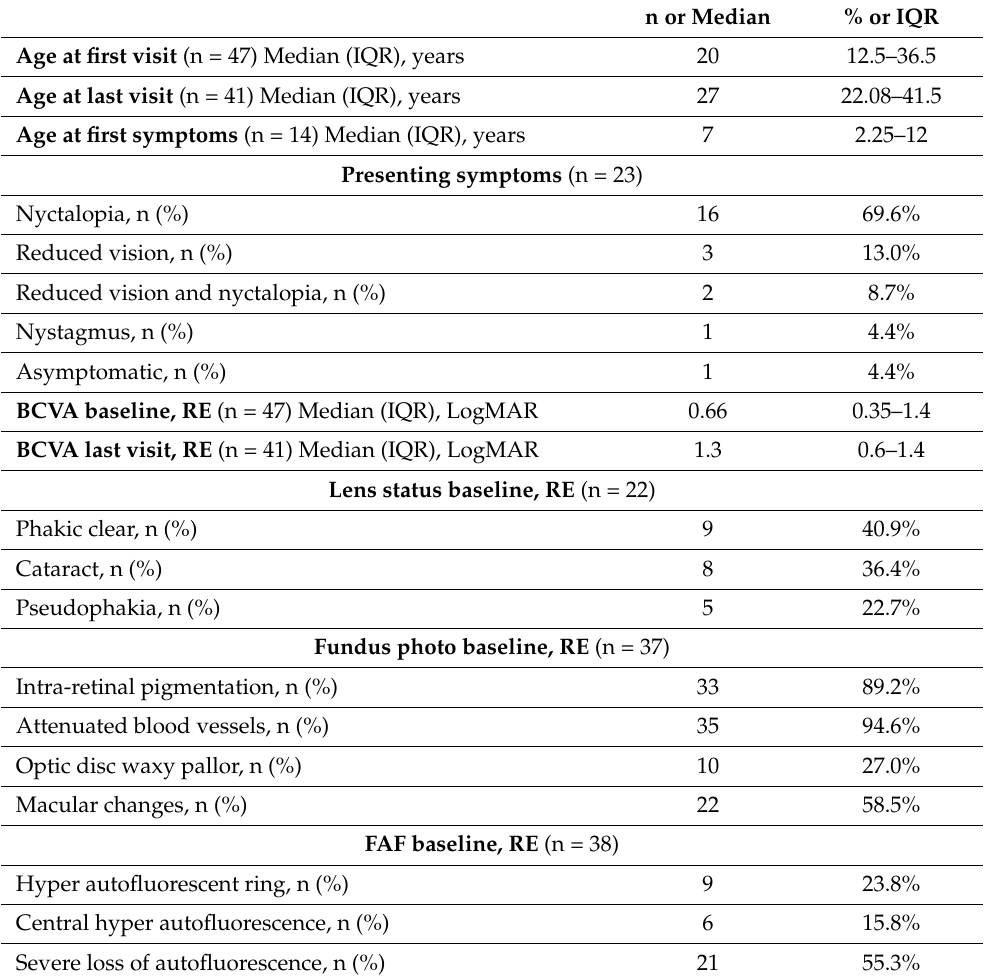
Table 1. Clinical characteristics and demographics of RP2 patients included in this cohort. Continuous variables are reported as the median and interquartile range (IQR), whereas categorical variables as count (n) and frequency